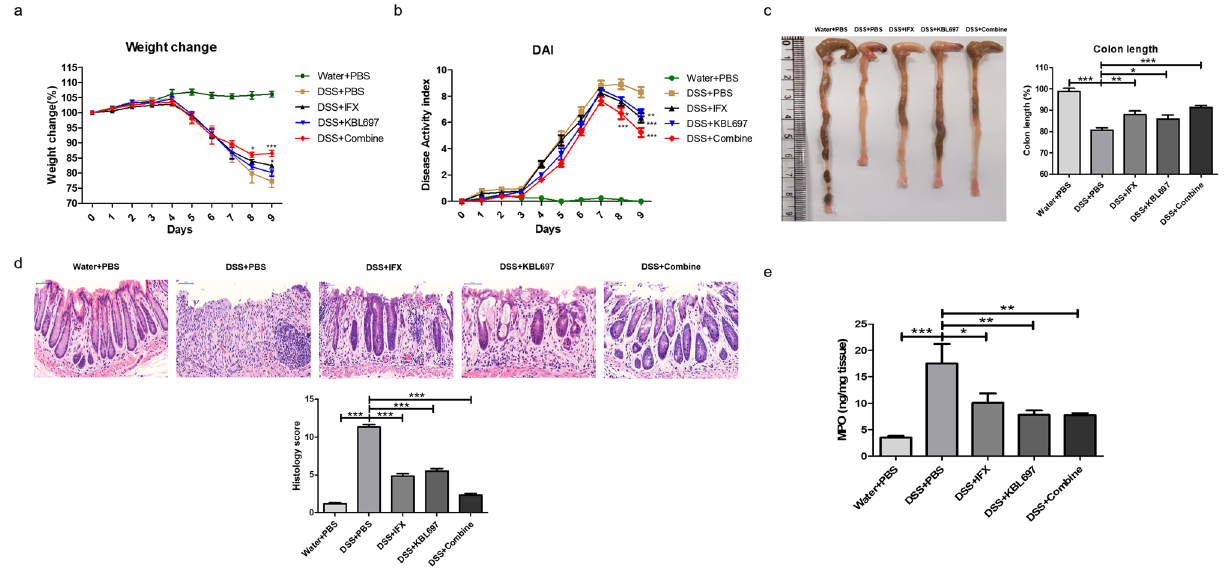
Figure 1. Improvements of colitis symptoms in mice via co-administration of L. gasseri KBL697 and Infliximab (IFX). ( a , b ) Body weights and DAI scores measured during experimental period. ( c , d ) Colon lengths and histology scores. ( e ) MPO levels. Statistical analysis was performed using one-way ANOVA with Dunnett’s post hoc test (* P < 0.05; ** P < 0.01; *** P <